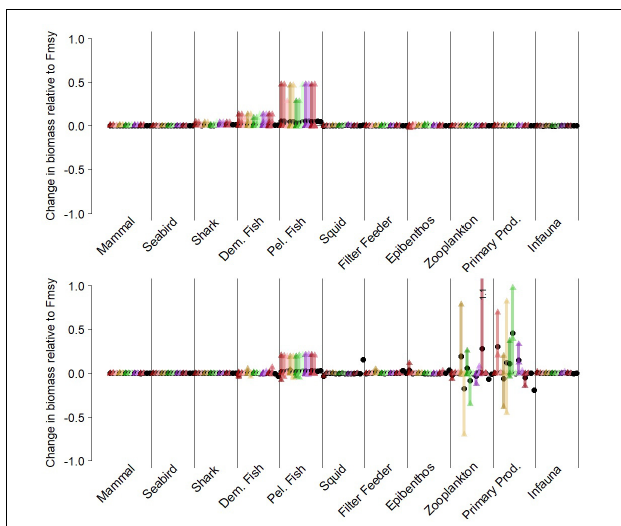
FIGURE 7 | Guild-level biomasses for simulations with a simple threshold harvest control rule for target fish (rule #2 in Table 1 ), scored against comparable “control” simulations with target fish F = Fmsy. Each simulation is represented by a unique color. Vertical bars represent the range of functional group responses, grouped by guilds, within each simulation. Small triangles are individual functional group responses, and black circles are the average responses per simulation. Top panel: California Current results for Pacific hake as target fish. Lower panel: Nordic and Barents Seas results for mackerel as target fish. Both target fish are in the pelagic fish